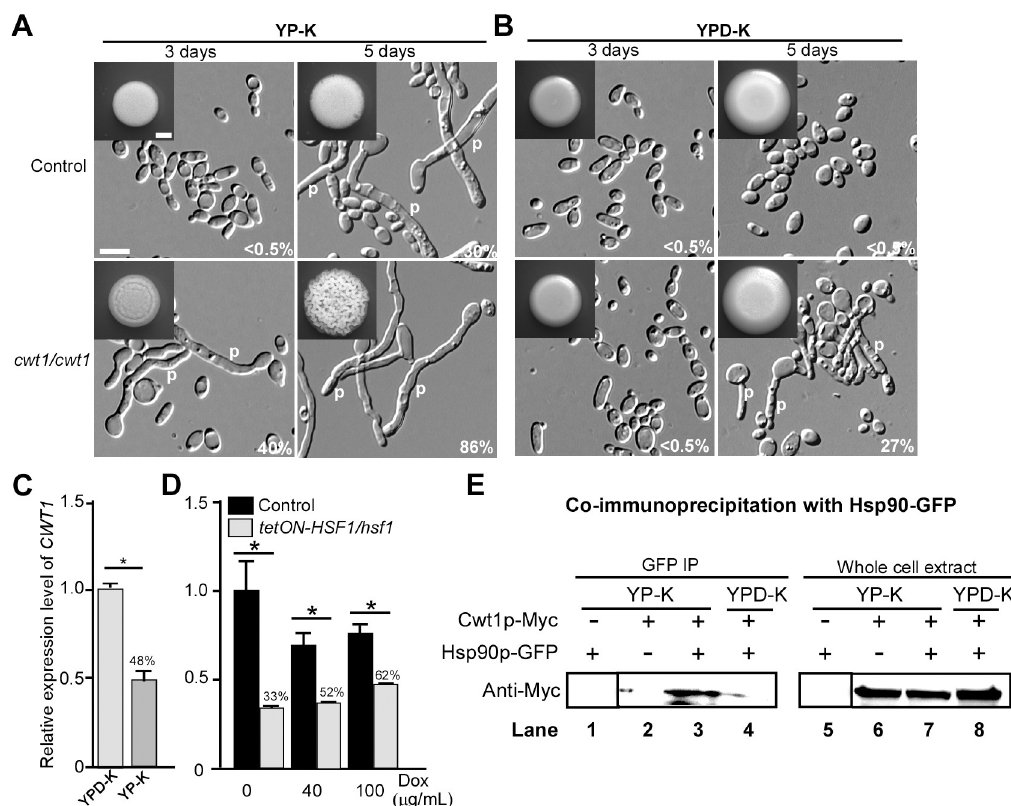
Fig 7. Role of the Cwt1 transcription factor in the induction of mating projections. (A and B) Morphologies of the control (GH1013 + ARG4 + HIS1 ) and cwt1/cwt1 mutant on YP-K (A) or YPD-K (B) medium. 1 × 10 5 cells of each strain were spotted on YPD-K and YP-K media and cultured at 25˚C for three or five days. Percentages of projected cells are indicated in the corresponding images. Scale bar for colonies, 2 mm (inset); scale bar for cells, 10 μ m. (C) Relative expression levels of CWT1 in YPD-K and YP-K media. Cells of C . albicans were spotted on YPD-K and YP-K media and cultured at 25˚C for five days. (D) Relative expression levels of CWT1 in the control (GH1013cartTA) and tetON-HSF1/hsf1 on YP-K medium. Error bars, standard errors of technical duplicates. � p < 0.05, two-tailed Student t test. Percentages indicate the ratio of gene expression in tetON-HSF1/hsf1 mutant relative to gene expression in control. The numerical data are presented in S3 Data . (E) Physical interaction of Cwt1 and Hsp90. Co-IP assays were performed using a strain with 13 × Myc-tagged Cwt1 and GFP-tagged Hsp90. Lanes 1–4, samples co-immunoprecipitated by the GFP antibody Sepharose and analyzed by immunoblotting with the anti-Myc antibody. Lanes 5–8, whole-cell extracts analyzed by immunoblotting with the anti-Myc antibody. Experiment was performed in biological replicate, and a representative image is shown. Arg, arginine; Cwt1, Cell Wall Transcription factor 1; Dox, doxycycline; GFP, green fluorescent protein; His, histidine; Hsf1, Heat Shock transcription Factor 1; Hsp90, Heat shock protein 90; IP, immunoprecipitation; Myc, Myc epitope tag; p, mating projection; tetON , tetracycline-induced; tetON-HSF1/ hsf1 , tetON -promoter–controlled conditional expression strain of HSF1 ; YPD-K, yeast extract-peptone-glucose-K 2 HPO 4 ; YP-K, yeast extract-peptone-K 2 HPO 4